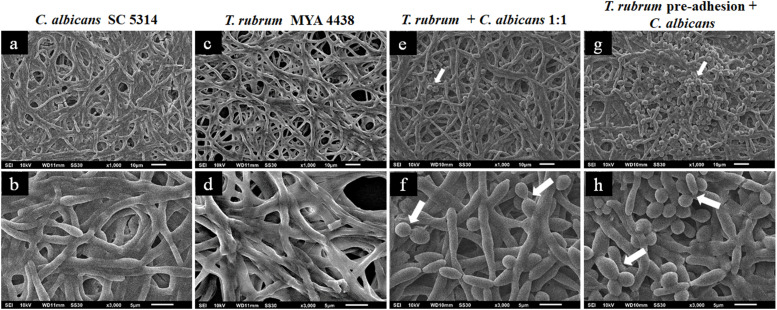
Scanning electron microscopies of C. albicans SC 5314 (a,b) and T. rubrum ATCC MYA 4438 (c,d) monospecies biofilms and dual-species biofilms of C. albicans/T. rubrum formed at a proportion of 1:1 (e,f) or formed with the addition of C. albicans suspensions after the pre-adhesion of T. rubrum biofilm (g,h). White arrows denote the blastoconidia of C. albicans.